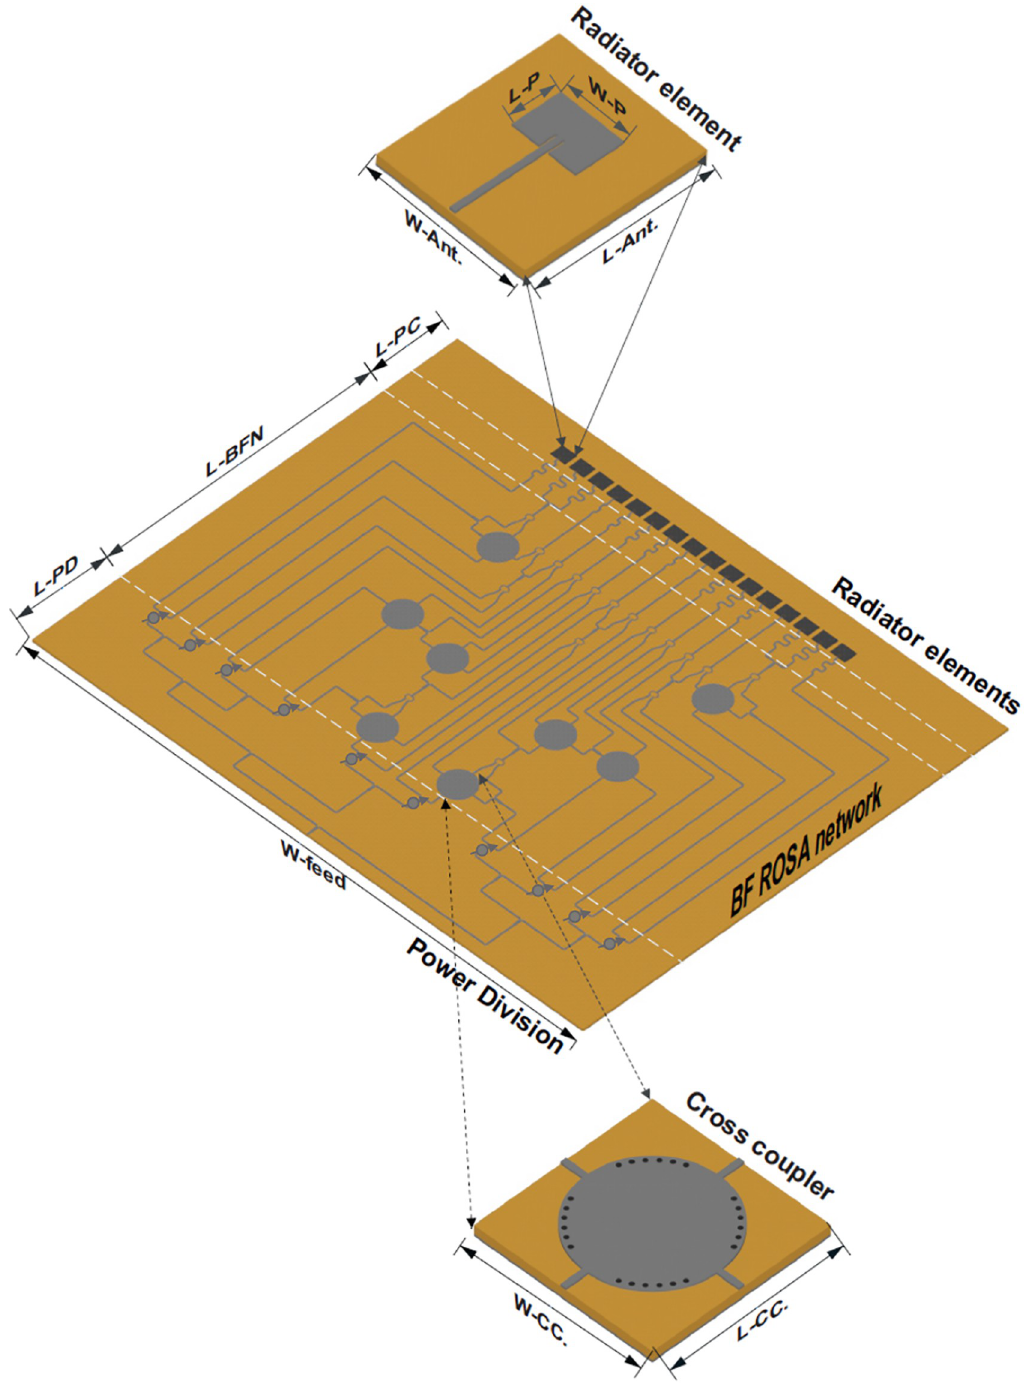
Fig 10. Schematic of the designed ROSA network, including power division, BFN, pase compensation and phase shifter units, for which the geometry parameters are L-PD = 17.54, L-BFN = 84.5, L-PC = 7.75, L-Ant. = 7.5, L-CC. = 8.9, W- feed = 2.3, L-p = 4.3, W-Ant. = 7.5, W-Track = 0.39, W-CC. = 8.9, W-P = 3.9, and tsub = 0.127 all in the unit of mm.